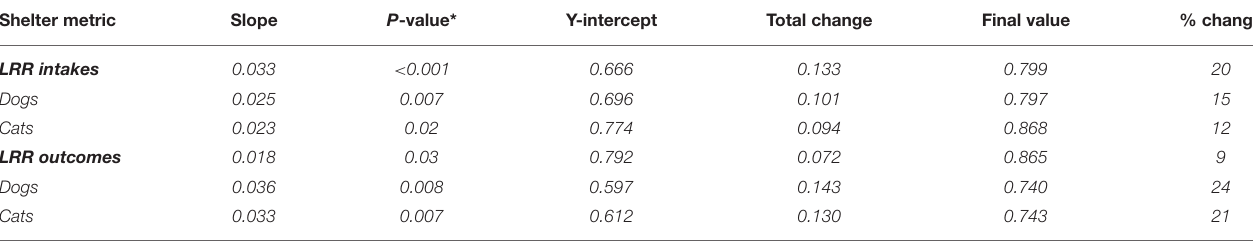
TABLE 3 | Results of linear regression analysis of dog, cat, and total live release rates as a function of total annual intakes and as a function of total outcomes by animal shelter organizations in the United States from 2016 to 2020. Shelter metric